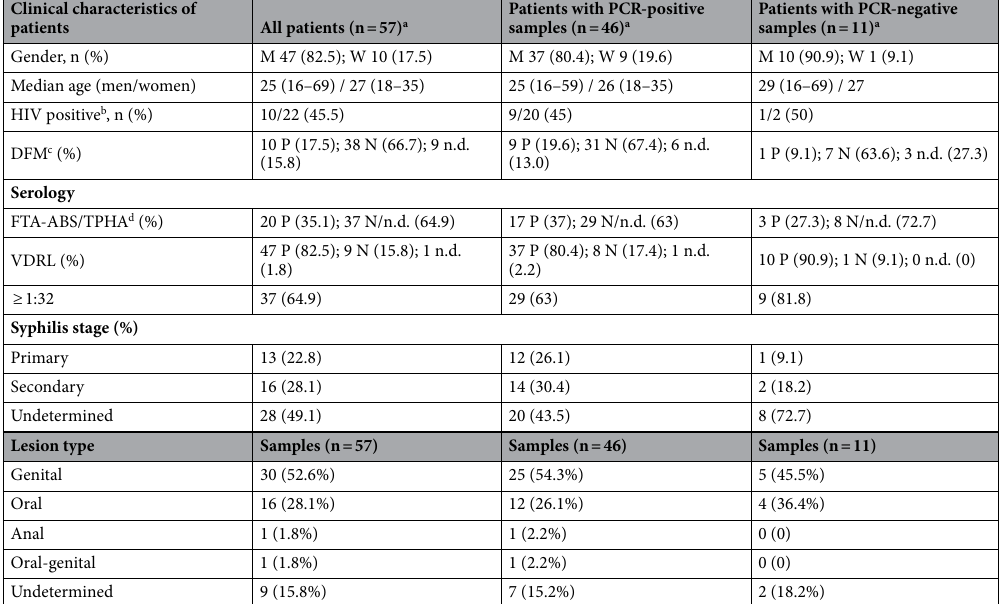
Table 1. Characteristics of 57 syphilis-positive patients with successful DNA isolation enrolled in this study during 2015–2019 in Buenos Aires, Argentina. a M men, W women, P positive, N negative, n.d. not determined. b HIV status was known only in 22 patients (38.6%). c DFM, dark-field microscopy. d FTA-ABS Fluorescent Treponemal Antibody Absorption, TPHA Treponema pallidum Particle Hemagglutination